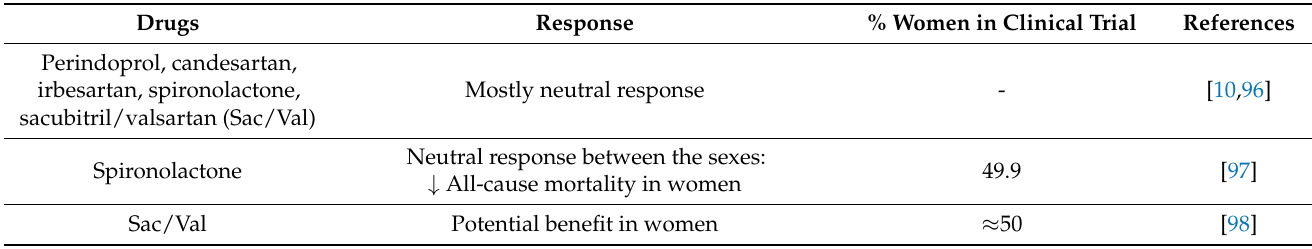
Table 1. Alternative therapies for